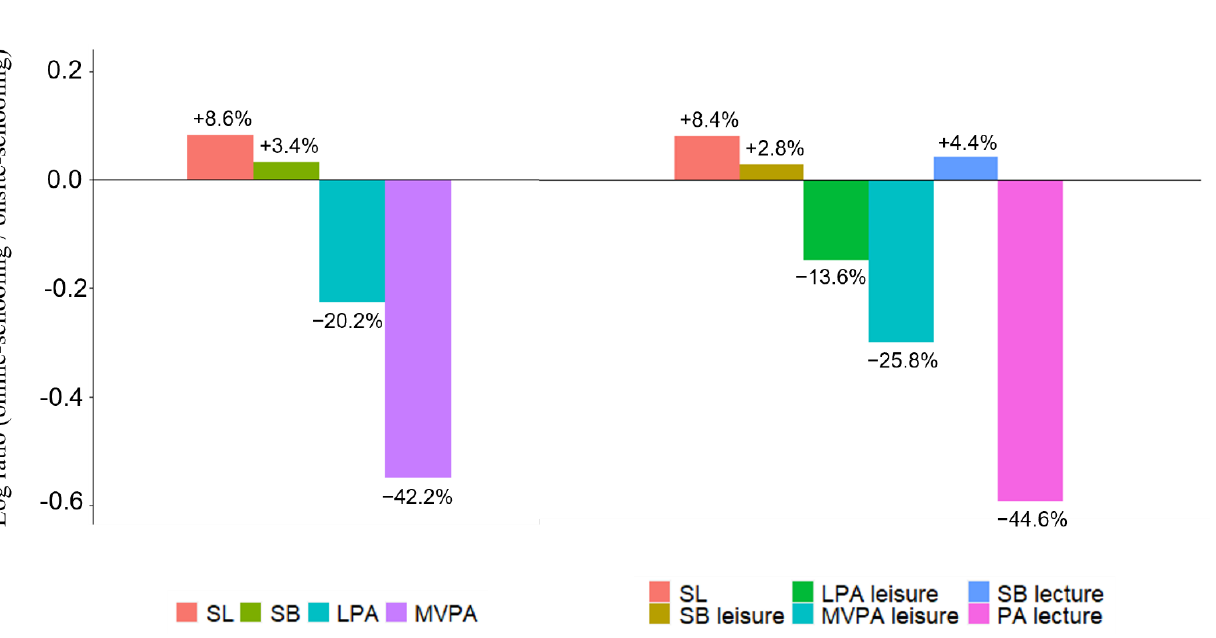
Figure 1. Geometric mean bar plot on log-ratios between compositional means while online-schooling and onsite-schooling conditions for: ( a ) 24-h movement behaviours, and ( b ) 24-h domain-specific movement behaviours. For example: geometric mean bar plot ( a ) indicates that on average students spent more time in SL (+8.6%) and SB (+3.4%), and less time in LPA ( − 20.2%) and MVPA ( − 42.2%) on days when they attended lectures from home (online) compared to when they attended lectures from school (% were calculated as: exp of log ratio × 100–100). Abbreviations: SL, sleep; SB, sedentary behaviour; LPA, light physical activity; MVPA, moderate-to- vigorous physical activity; PA, physical